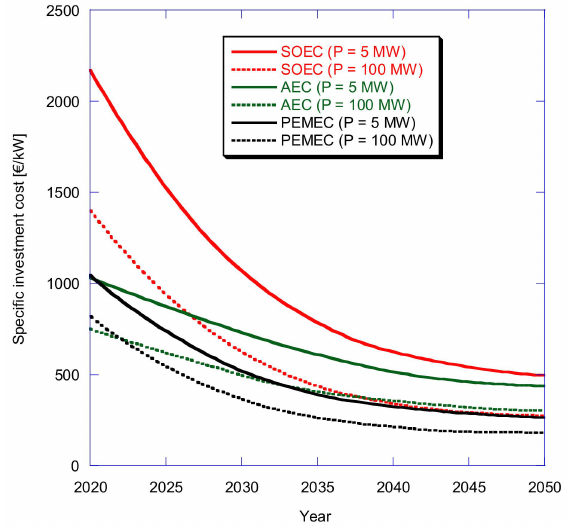
Figure 6. Specific cost development of electrolysis systems related to scaling effects and technological learning (figure elaborated using data by